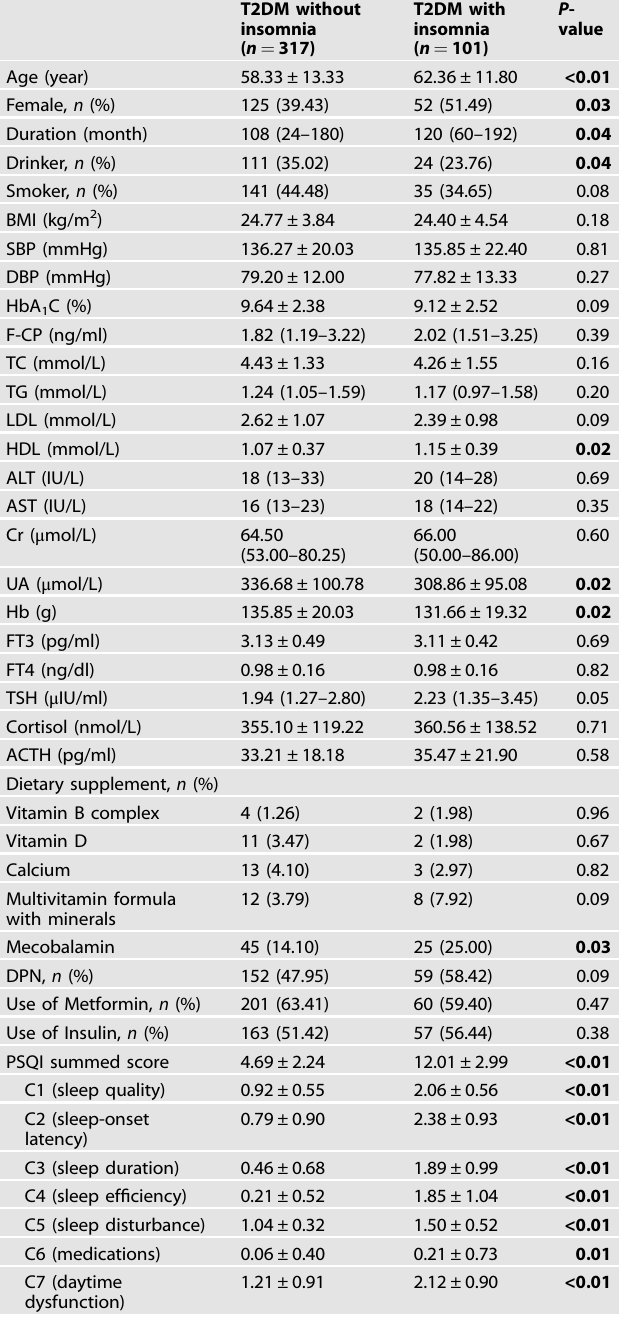
Table 1. General characteristics of